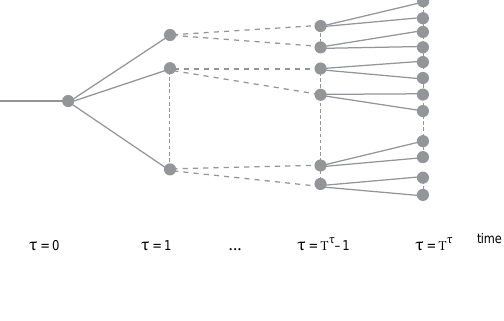
Fig. 6. Multi-stage scenarios